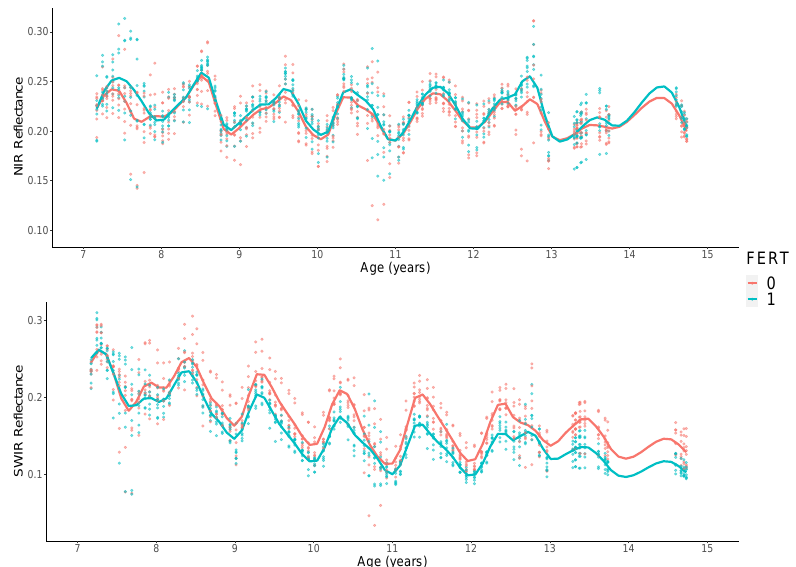
Figure 8. Changes in average Landsat 5 TM and 7 ETM+ Band 4 (NIR) and Band 5 (SWIR) reflectance values by fertilization status across the 16 study plots at the Southeast Tree Research and Education Site (SETRES) in Scotland County, North Carolina. Points show the Landsat 5 TM and 7 ETM+ observations used in the